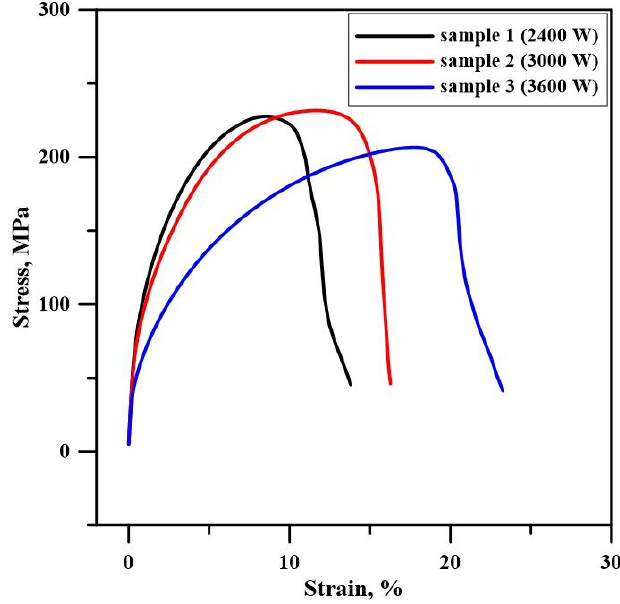
Figure 6. Tensile characteristics of the EBW samples. Table 4. Tensile test results.